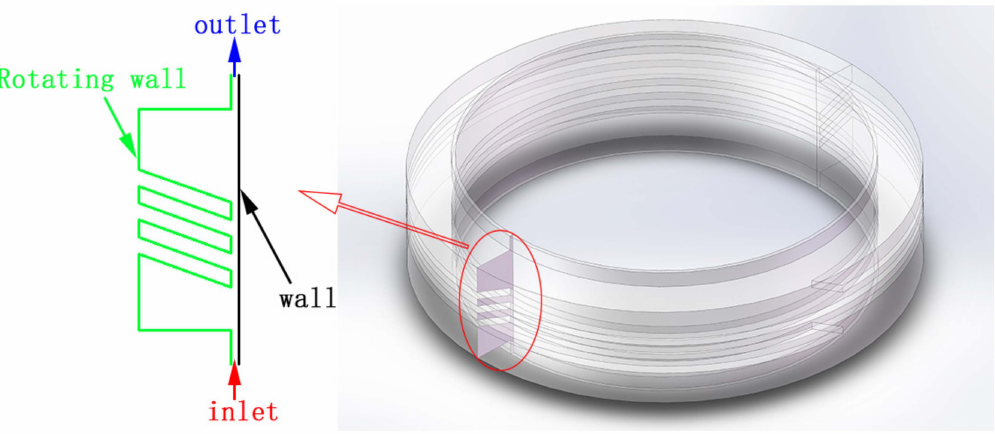
Figure 2. Boundary